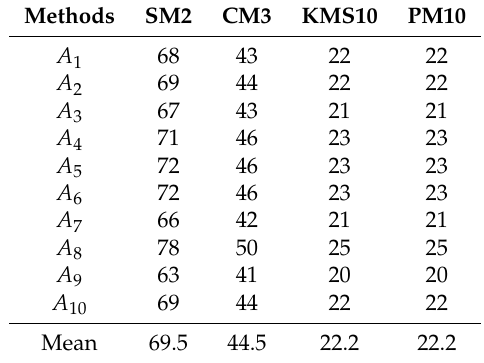
Table 1. Comparison based on the number of iterations and the required mean in Experiment